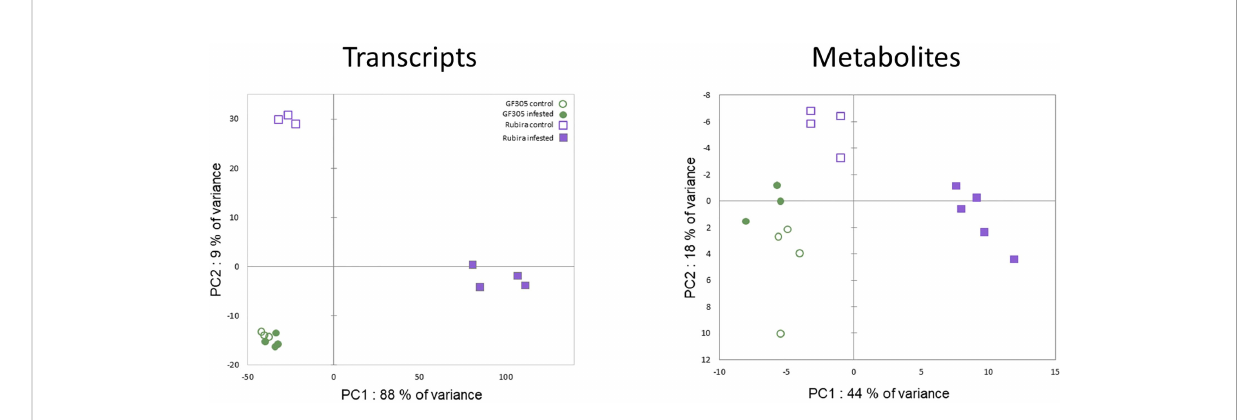
FIGURE 2 PCA score plots on raw transcription count data and metabolite semi-quantitative